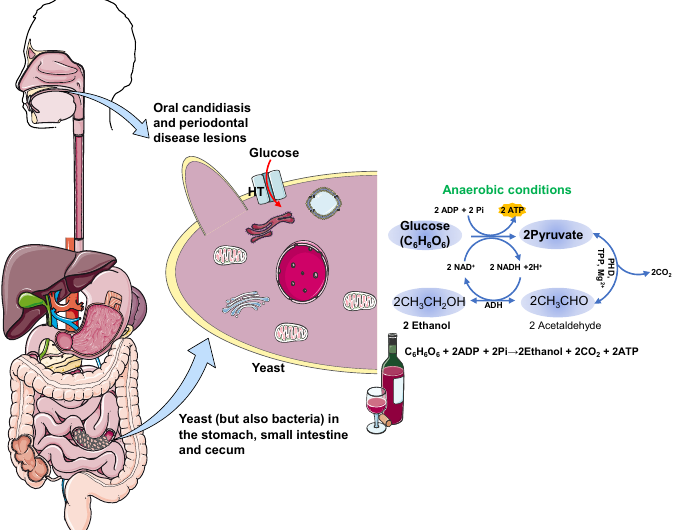
Figure 1. Yeast and bacterial fermentation process of the metabolism of glucose to ethanol. First, glucose is transported into the cell by the hexose transporter (HT). The process then involves the decarboxylation of pyruvic acid to acetaldehyde under anaerobic conditions, followed by the reduc- tion of acetaldehyde to ethanol. ADH, alcohol dehydrogenase; ADP, adenosine diphosphate; ATP, adenosine triphosphate; NAD + , nicotinamide adenine dinucleotide; P, phosphate; PHD, pyruvate decarboxylase (an enzyme absent in humans but present in certain yeasts and bacteria); TPP, thia- mine pyrophosphate.